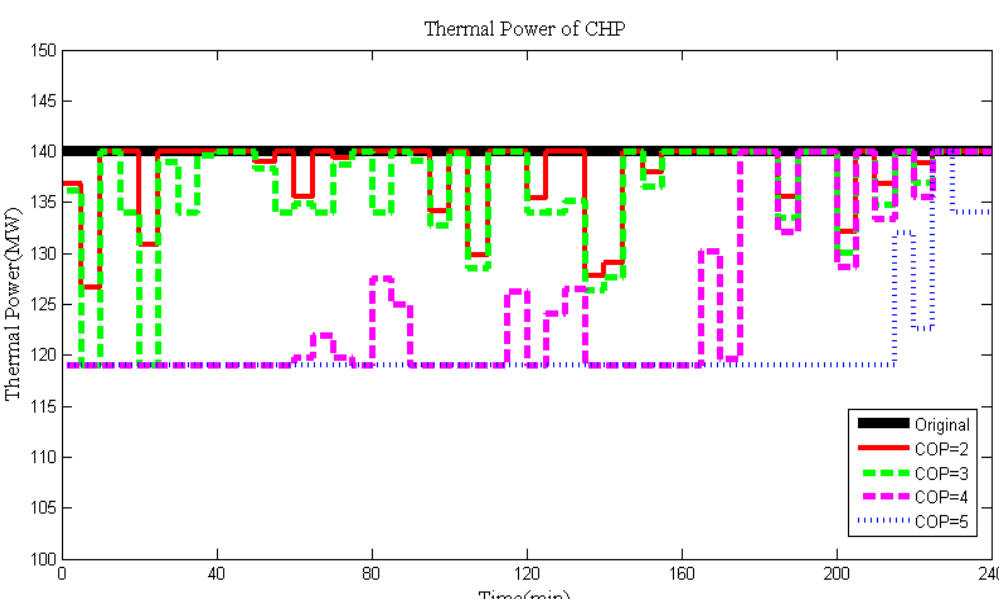
Figure 8. Adjustment of Thermal Power of CHP.